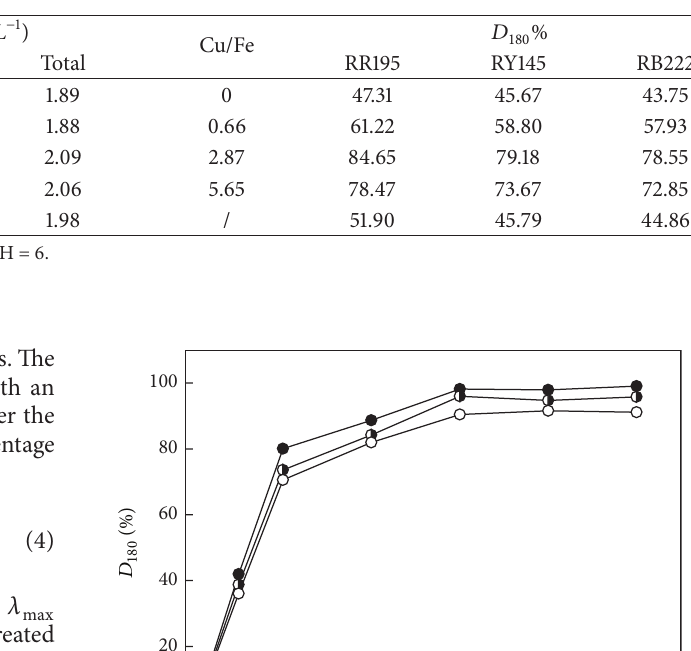
Table 1: Effect of Cu/Fe ratio on decoloration of three reactive dyes.